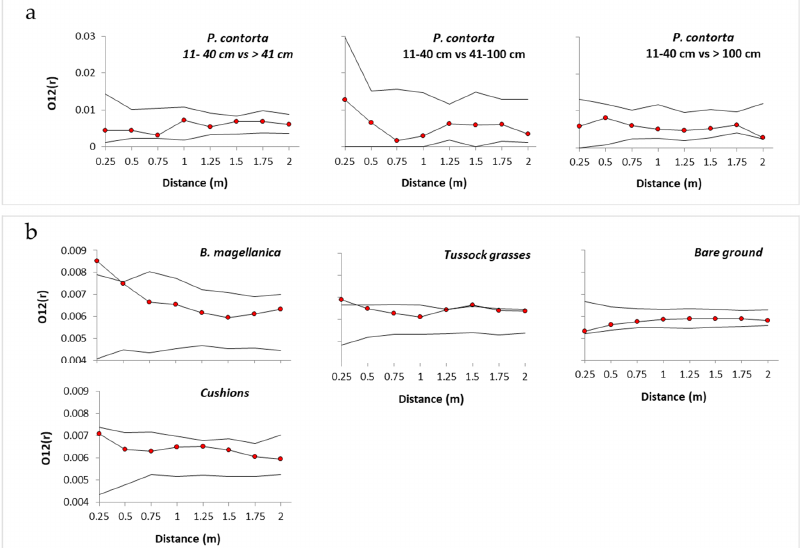
Figure 8. Spatial distribution patterns between ( a ) different Pinus contorta height classes and ( b ) Pinus contorta seedlings of 11 to 40 cm height and each ground cover type: B. magellanica , tussock grasses, bare ground, and cushions. The O12( r ) estimator indicates the probability of finding a cell of category 2 at a distance r away from a cell of category l. Continuous lines represent confidence envelopes from the 99 Montecarlo simulations. If the O-ring function (red dots) exceeds the upper confidence level, it indicates an aggregated pattern of the species or plants involved. If the function locates below the lower confidence interval, then it indicates a repulsion or regularly spatiated distribution of the plants. If the function is located between both confidence intervals, then the distribution of the plants does not differ from the CSR pattern.